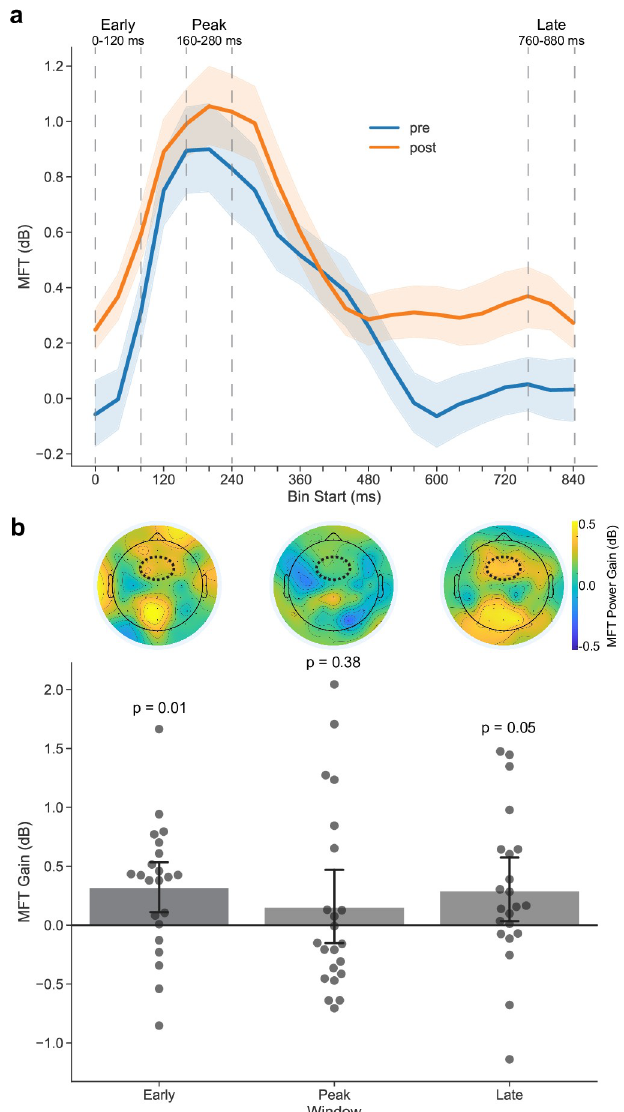
Fig 2. Changes in primary outcome metrics: Neural markers of attention. a Time course of midline frontal theta (MFT) pre- and post-intervention at each 40 ms time bin during the perceptual discrimination task, where 0 ms represents stimulus onset. Solid lines represent the mean and shaded areas represent 95% bootstrapped confidence intervals (1000 bootstrap iterations). b Intervention-related improvements in MFT at early, peak, and late 120 ms composite windows, also illustrated through topographic heat maps with the 6 electrodes of interest highlighted with a dotted bounding box. Data are presented as mean ± 95% bootstrapped confidence intervals (1000 bootstrap iterations), and circles represent individual participants. P-values represent repeated-measures ANOVAs comparing pre- and post-intervention MFT at each composite window.